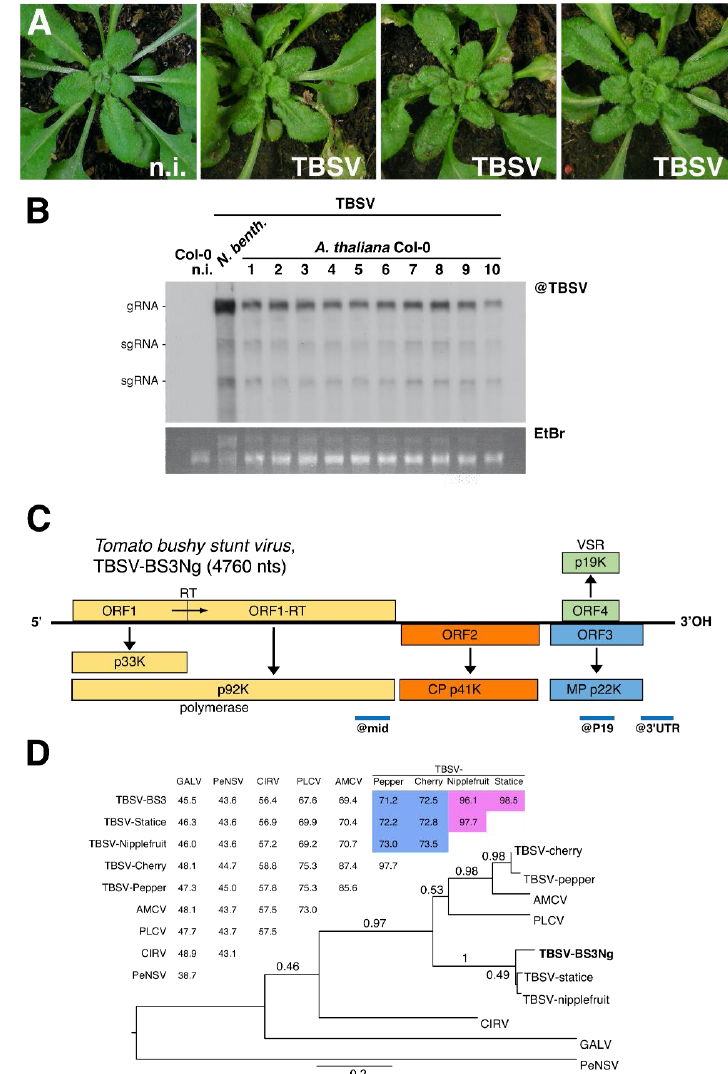
Figure 1. Characterization of a Tomato bushy stunt virus (TBSV) isolate infecting Arabidopsis thaliana . ( A ) A. thaliana Col-0 plants systemically infected by TBSV, 9 days post-infection (dpi). A non-infected (n.i.) plant is shown on the far left. ( B ) Northern blot analysis of RNA from systemically infected leaves from individual Col-0 plants 9 days after infection with TBSV. Out of the inoculated plants 10/10 resulted to be systemically infected. On the left, RNA from non-infected Col-0 and TBSV-infected N. benthamiana were used as negative and positive controls, respectively. Ethidium bromide staining (EtBr, bottom) was used as a loading control. (C) Schematic representation of the genomic organization of TBSV. Boxes represent predicted ORFs encoding the p33K and phylogenetically conserved polymerase (ORF1), the capsid protein (CP, ORF2), the movement protein (MP, ORF3) and the silencing suppressor (VSR, ORF4). RT: translational read-through of the termination codon. The blue lines below indicate the genomic segments detected by the probes used to detect small RNA in this study, referred to as @mid, @P19 and @3′UTR. ( D ) Maximum likelihood tree inferred from 10 complete CP amino-acid sequences of di ff erent Tombusvirus species. Table shows the CP amino acid identity percentage. The intra-TBSV species percentages are highlighted in pink and those falling outside the species demarcation are highlighted in blue. The scale bar corresponds to the number of substitutions per